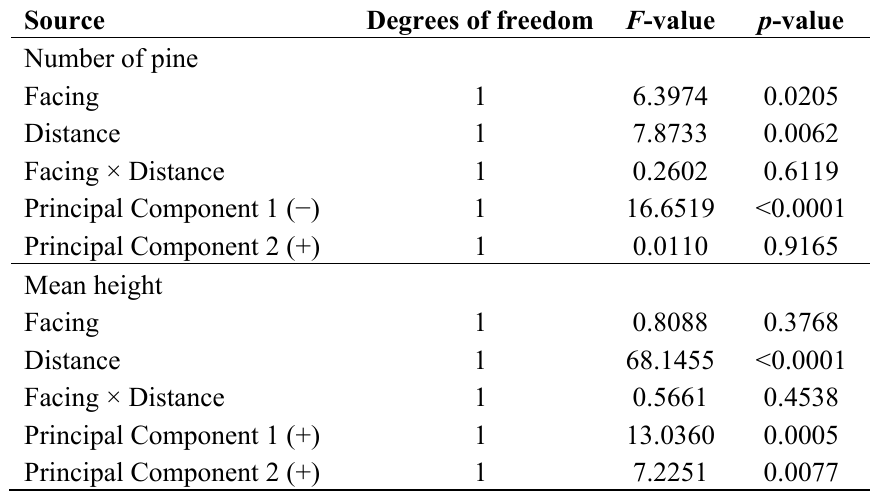
Table 2. The influence of the fixed effects distance from the forest edge and the facing of the edge towards north or south on the number and height of pine seedlings along transects across forest edges. Associations with principal components based on vegetation analyses are also shown. Principal Component 1 is primarily explained by the abundance of lichens (negative relation) and mosses (positive relation), and Principal Component 2 is primarily explained by the abundance of heather (positive